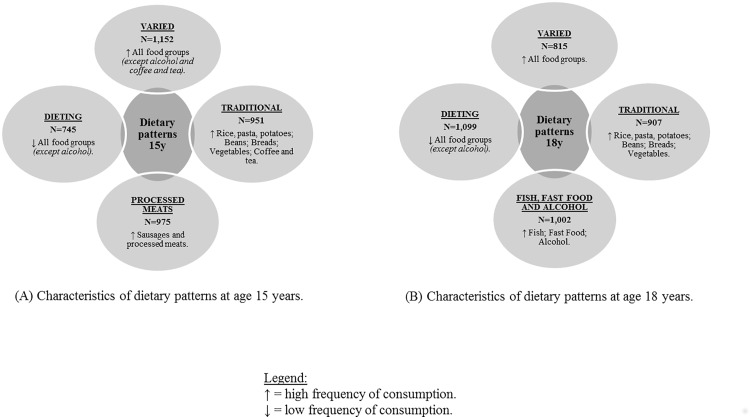
Dietary patterns.(A) Characteristics of dietary patterns at age 15 years. (B) Characteristics of dietary patterns at age 18 years.